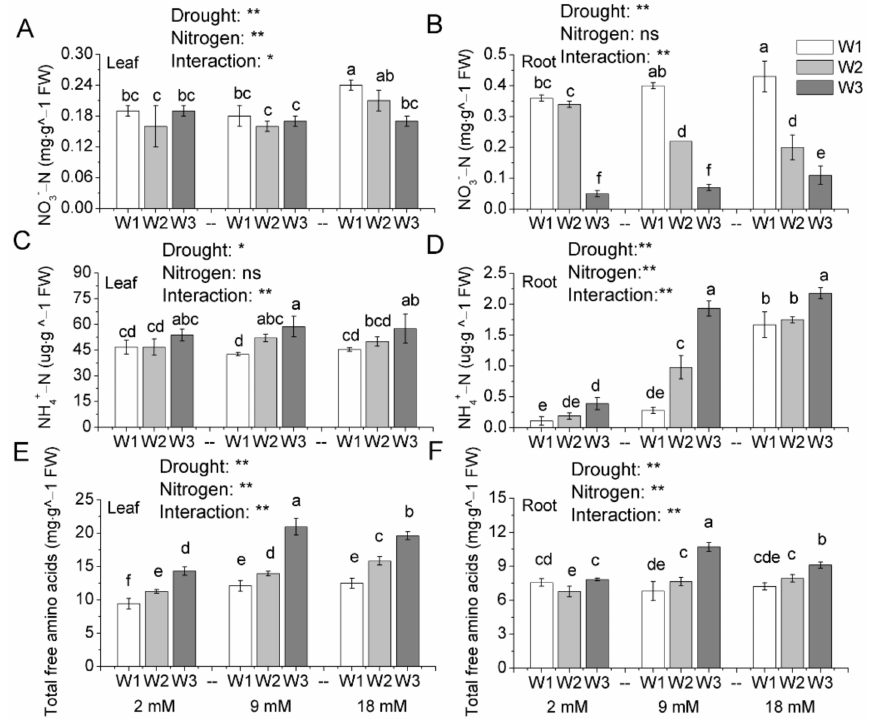
Figure 4. NO − -N content ( A , B ), NH + -N content ( C , D ) and total free amino acids content ( E , F ) in 3 4 leaves and roots of pakchoi at the end of the experiment. W1: 0 g · L − 1 PEG 6000, blank; W2: 60 g · L − 1 PEG 6000, mild drought stress; W3: 120 g · L − 1 PEG 6000, moderate drought. Bars with the different letters indicate significant difference ( p < 0.05). Error bars represent the standard deviation. p -values of the ANOVAs of drought, nitrogen supply, and their interaction are indicated. ns, not significant. * p < 0.05. ** p <